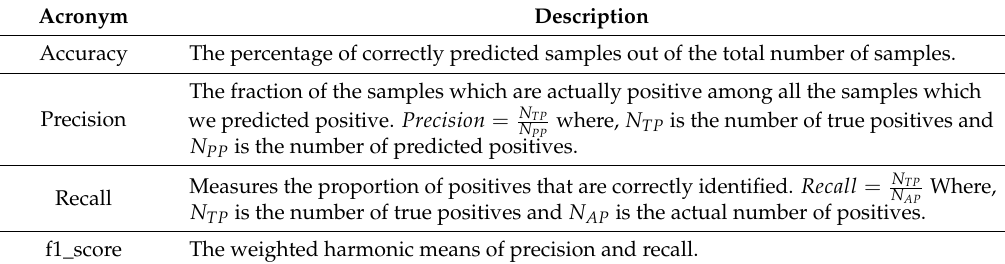
Table 2. Performance metrics.